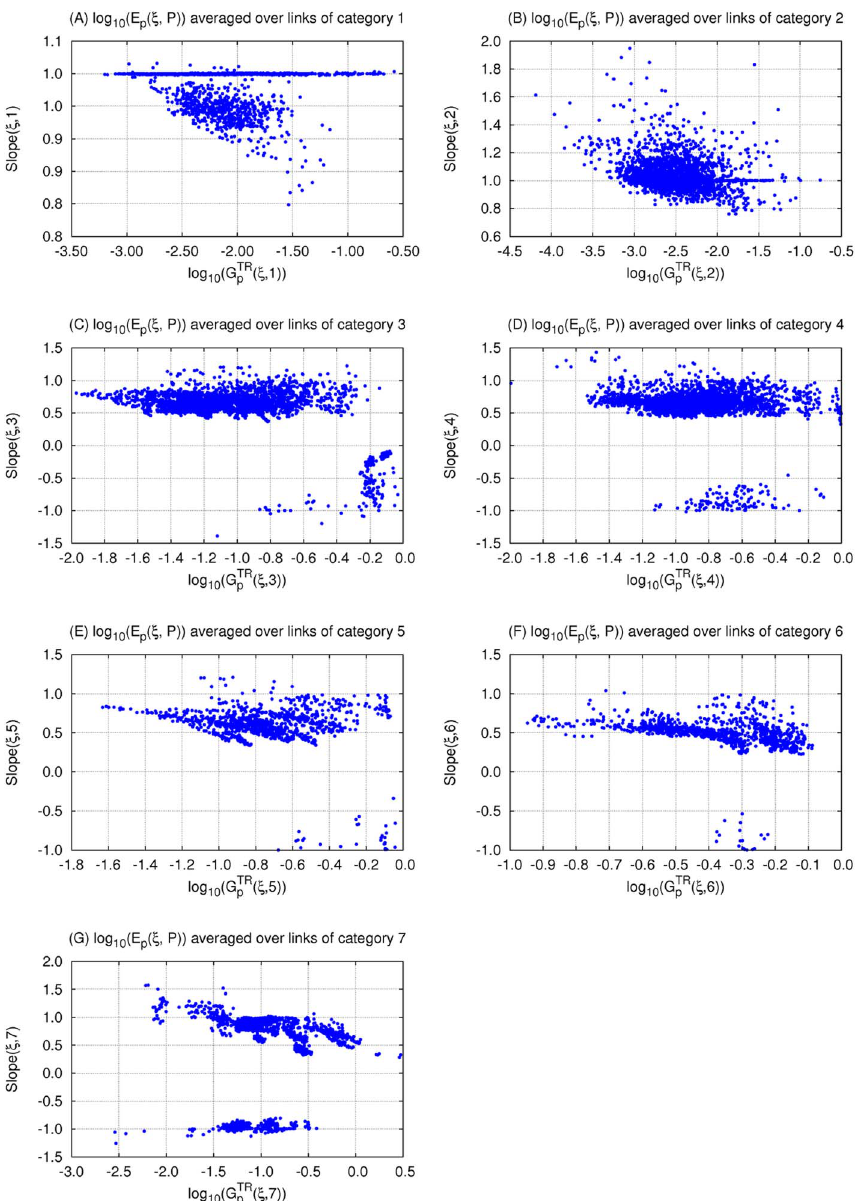
Figure 10. The slopes within the networks of each 3-node topology divided into 7 categories. Within each topology j , the overall robustness to parameters in category j ~ 1,2, (cid:2)(cid:2)(cid:2) 7 is shown versus slope j , j ð Þ , the slope of the regression line between log 10 E I j , ~ PP (cid:2) (cid:3)(cid:2) (cid:3) , for j =1 (A), 2 (B), 3 (C), 4 (D), 5 (E), 6 (F), and 7 (G). log 10 E p j , ~ PP , j